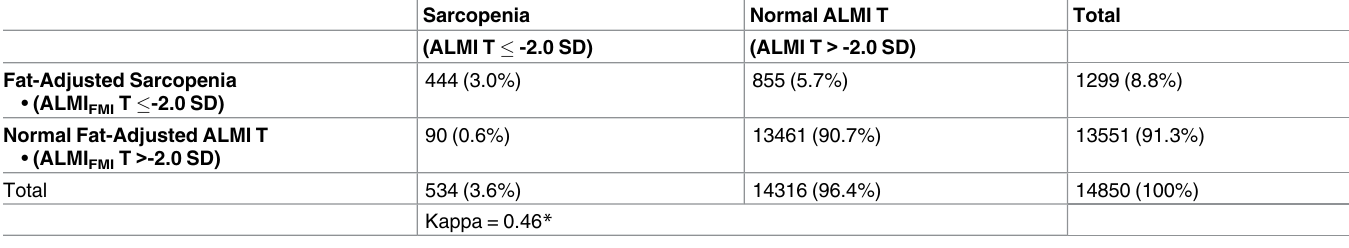
Table 4. Assessment of the concordance between standard and fat-adjusted measuresof sarcopenia (as defined as an ALMI greater than 2 SD below the mean for 20–40